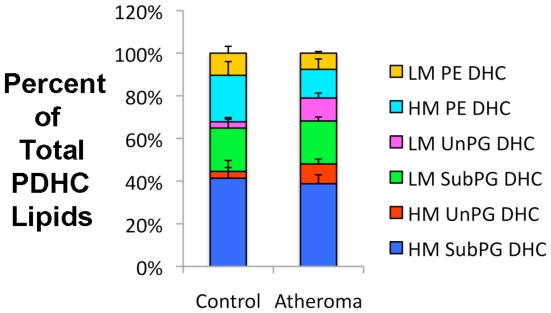
Recovery of bacterial phosphorylated dihydroceramides in paired patent artery and atheroma samples.For each carotid endarterectomy sample, the patent artery segment of the proximal common carotid artery was excised from the grossly evident atheroma located within the carotid sinus. The paired tissue samples were separately extracted for lipids as described in the Methods. A defined amount (approximately 3 µg of total lipids in 5 µl of HPLC solvent) of each lipid extract was analyzed by MRM-MS and the recovery of each lipid class is depicted as the percent of the total ion abundance of the quantified PDHC lipids. The percentages of PDHC lipids are depicted (means and standard errors) for five paired control and atheroma lipid extracts. Significant differences between control versus atheroma lipid extracts were shown only for the percentages of HM UnPG DHC and LM UnPG DHC lipids (p = 0.0144 and p = 0.0258, respectively, by paired t test). Though not shown, the mean abundances of PDHC ions per µg of total lipid extract were at least 33 times higher for the control artery samples compared with the atheroma samples.